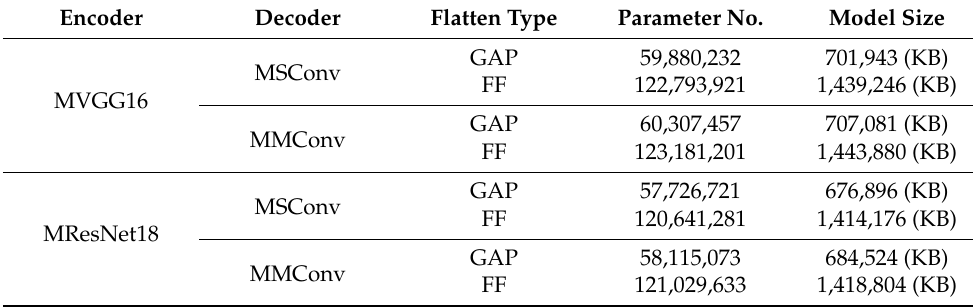
Table 3. Parameter numbers and model size of VoxGen with FF or